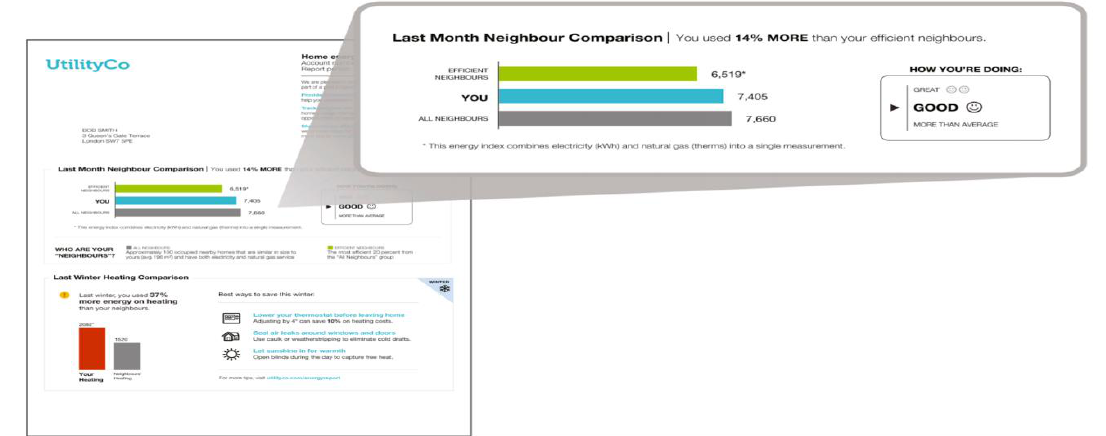
Figure 4: A sample energy bill sent by company Opower to consumers that displays the energy consumed along with embedded nudges towards more energy-efficient future behaviour. Figure source: